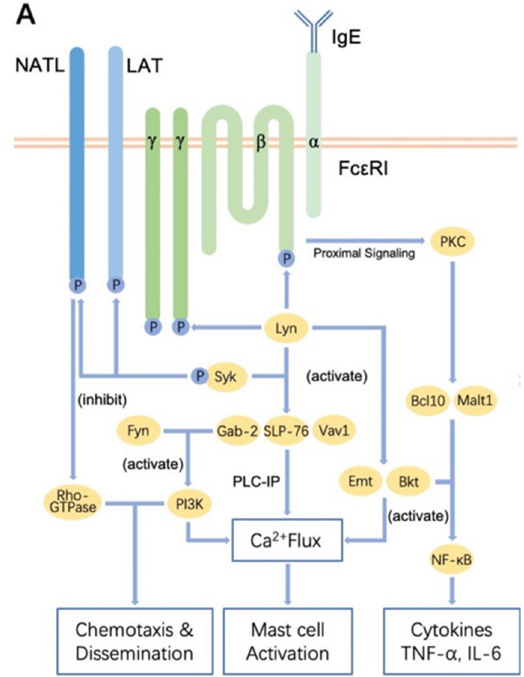
Figure 3. Regulation of receptor-mediated mast cell activation. IgE-Fc ε RI is the most classical mechanism of mast cell activation, which mainly relies on the Lyn-Syk and Fyn pathways to activate mast cells. Image of mast cell activation adapted and modified from Zhang, et al. [81].